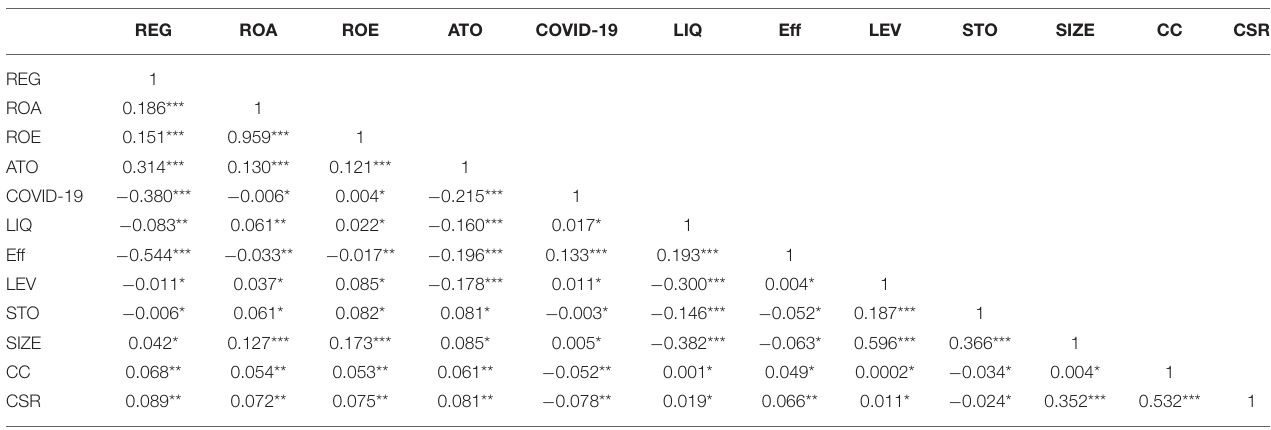
TABLE 3 | Correlation analysis results all variables.